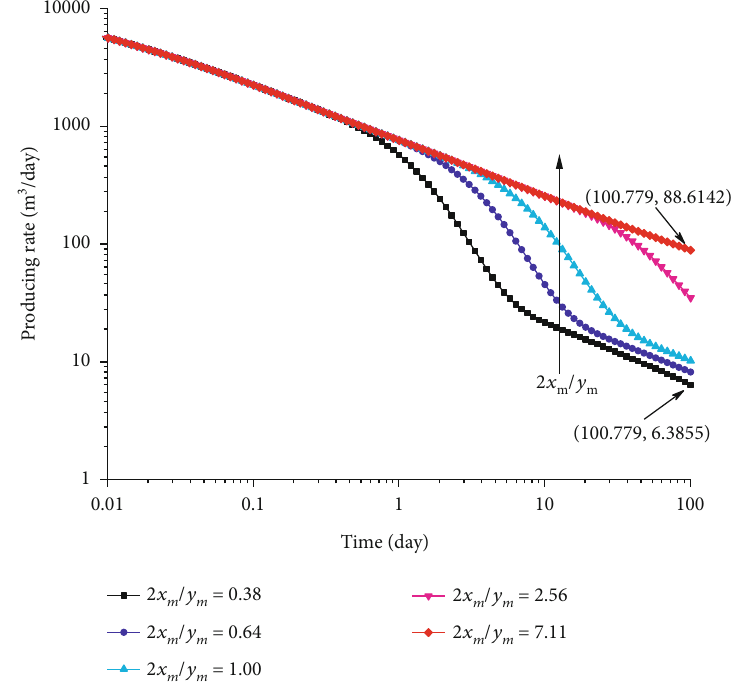
Figure 9: The e ff ect of SRV shape on production (constant